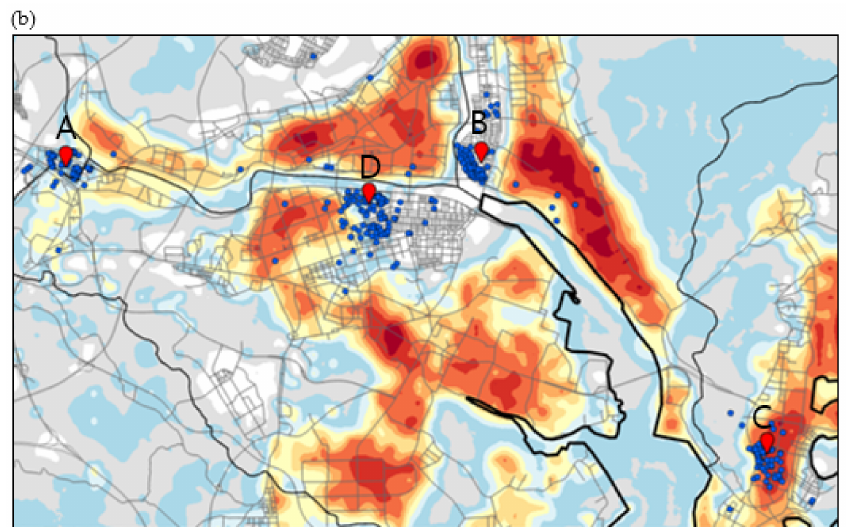
Figure A2. Noise map based on noise level estimated from LUR model by each school and subjects in 2008 ( a ) and 2018 ( b ). The locations of each subject are indicated by blue dots and schools by red location symbols. Except for school ‘c’, the overall noise level around schools seemed to have been decreased in 2018 ( a ) compared to that of 2008 ( b ). A, Gulhwa represents the coastal environment; B, Myeongchon represents the residential area; C, Yangji represents the industrial area; D, Samshin represents the downtown